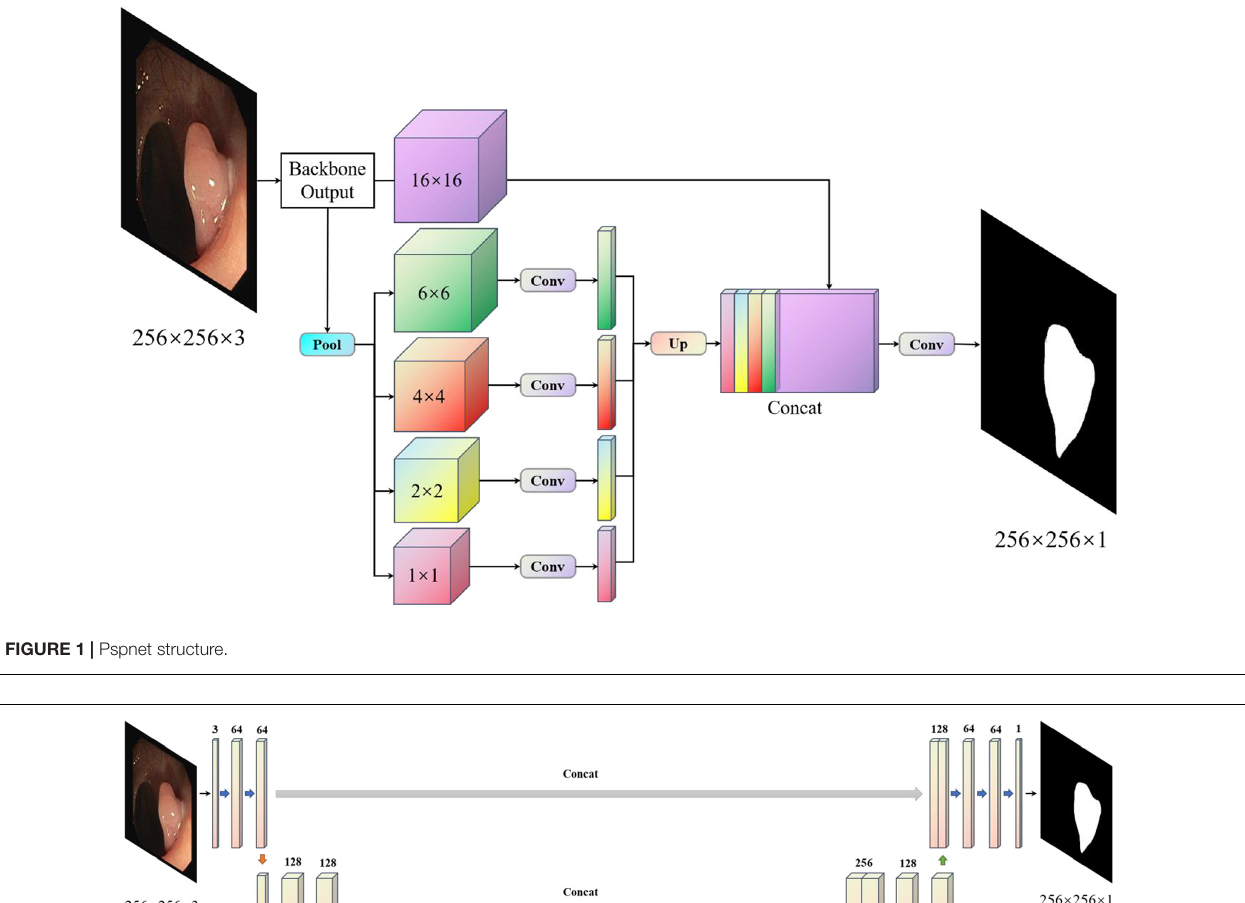
FIGURE 1 | Pspnet structure.